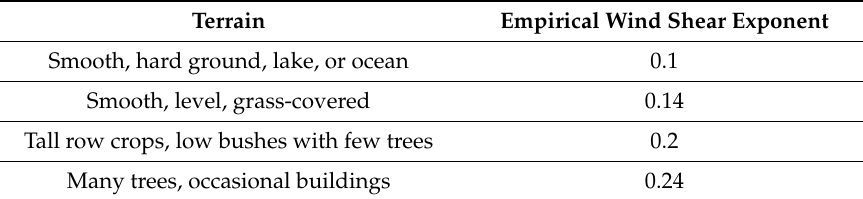
Table 1. The empirical wind shear index